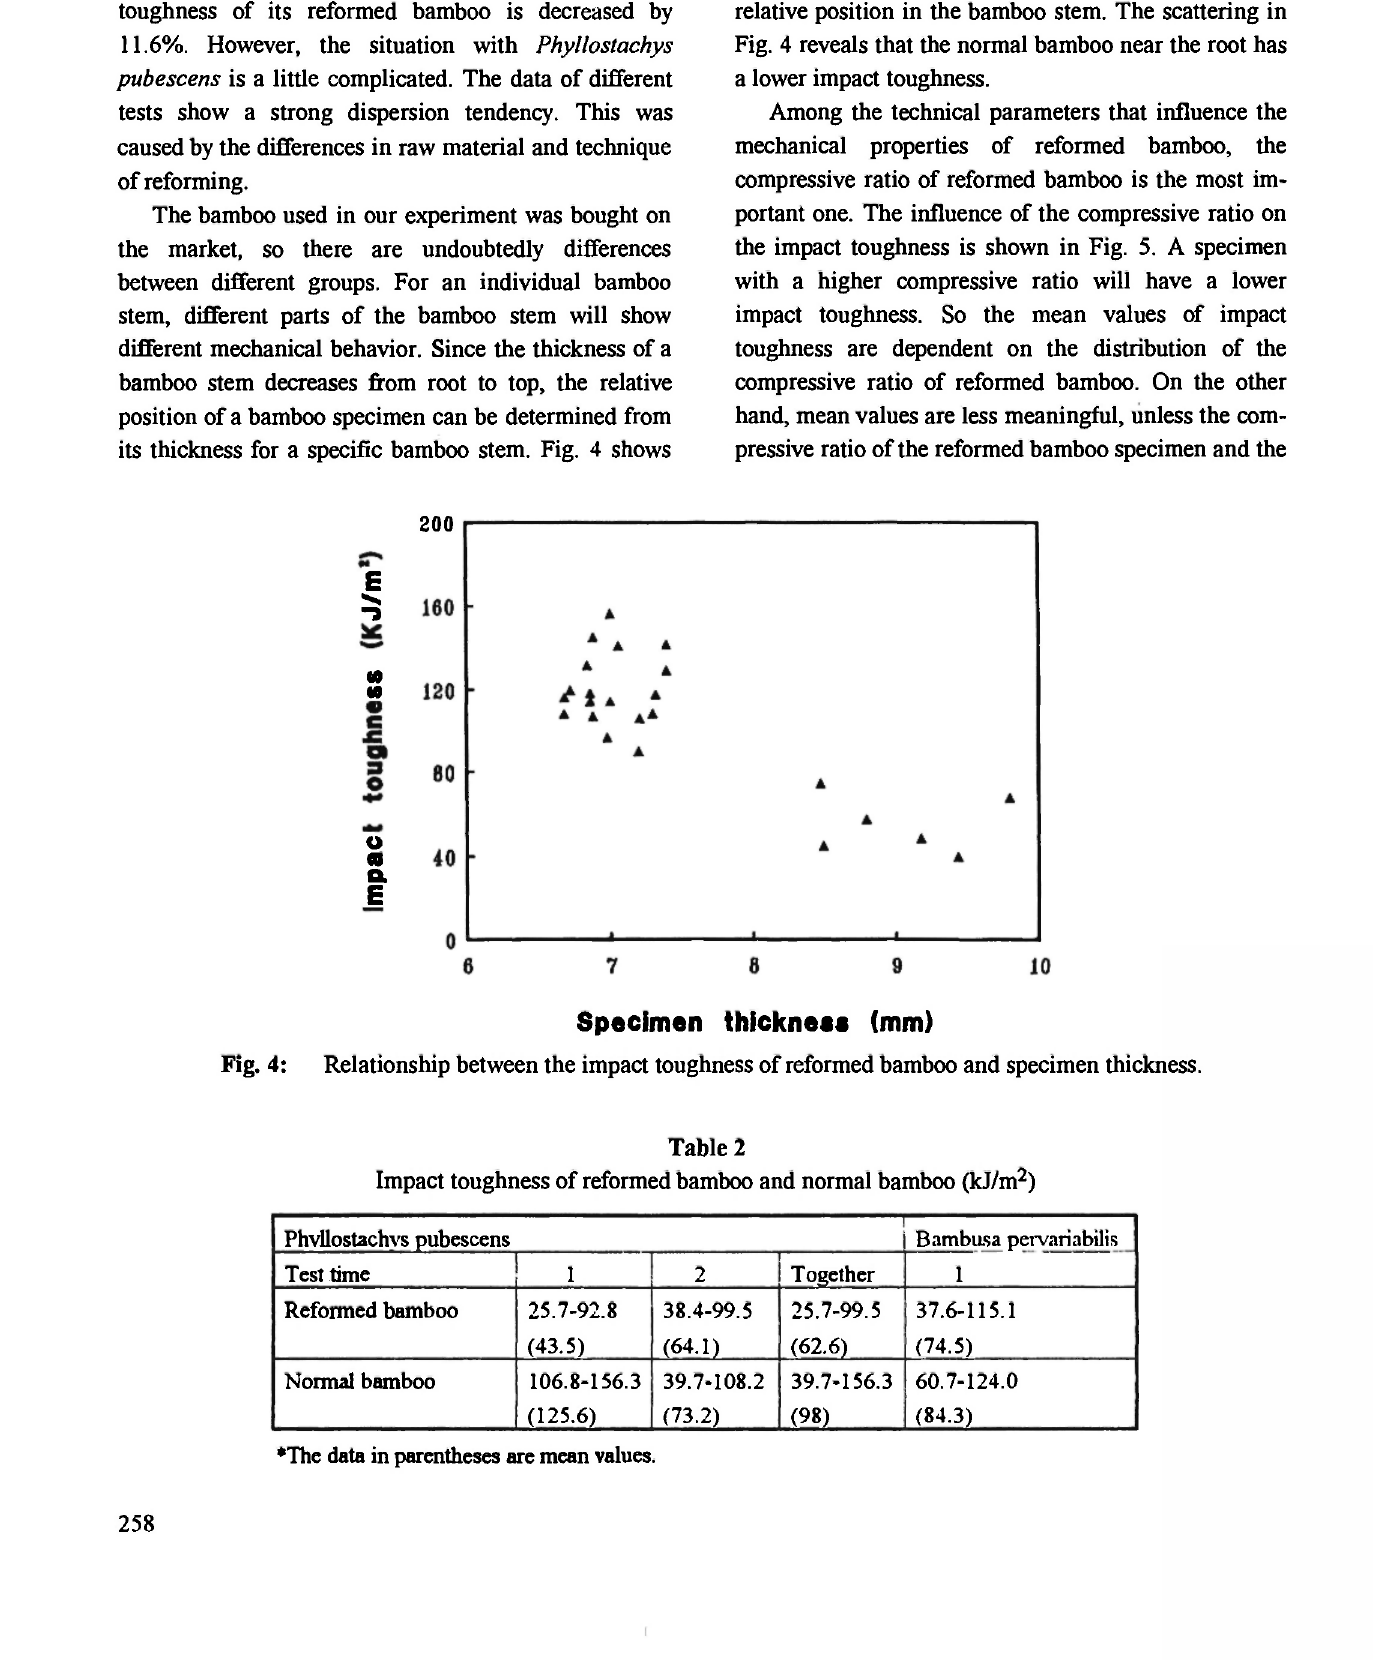
Impact toughness of reformed bamboo and normal bamboo (kJ/m 2 ) Phvllostachvs